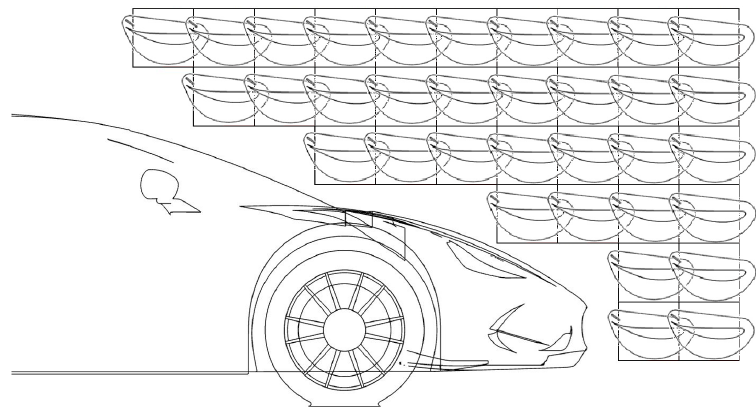
Figure 17. Visualization of the analyzed positions of the front